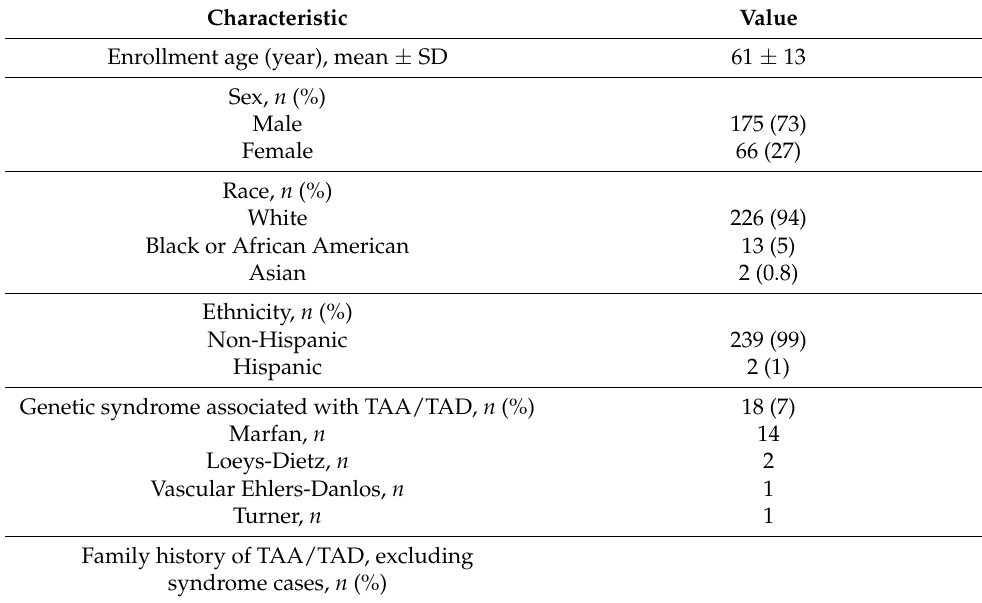
Table 1. Demographic and clinical characteristics in study cases ( N = 241).